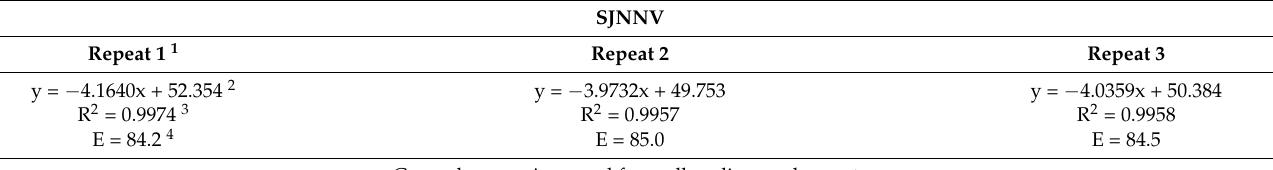
Table 4. Reliability of the quantification using purified virus as standard.